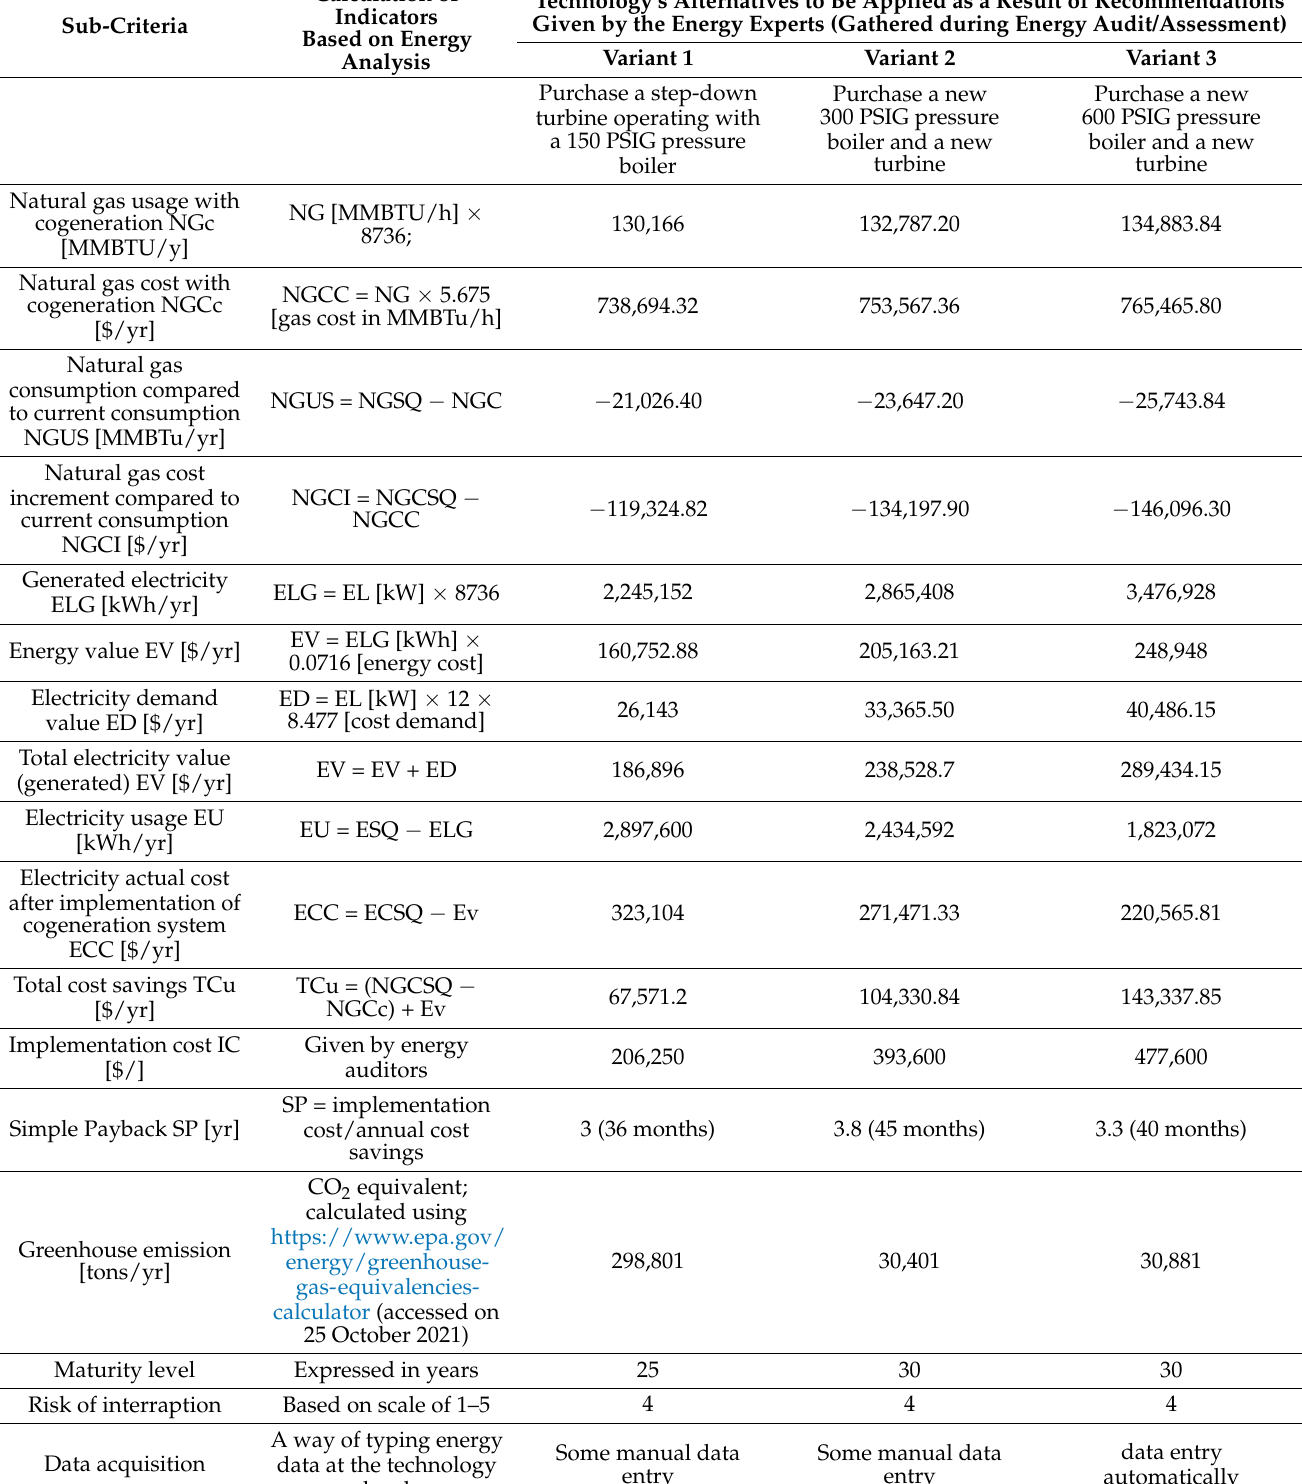
Table 3. Data collection and potential technology alternatives suggested by the energy experts for making decisions on the selection of an optimal energy technology